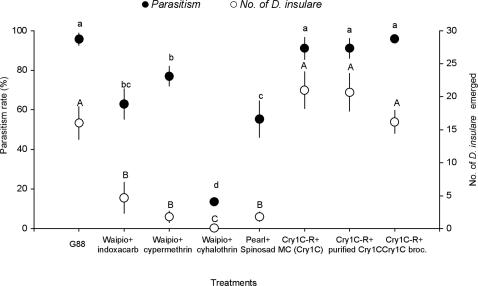
Parasitism rate (%) and the number of Diadegma insulare emerged from different Plutella xylostella strains treated with formulated insecticide, Bt toxin or left untreated.Means (±SE) marked with different lower-case letters or capital letters are significantly different based on Fisher's LSD mean separation test (P<0.05).